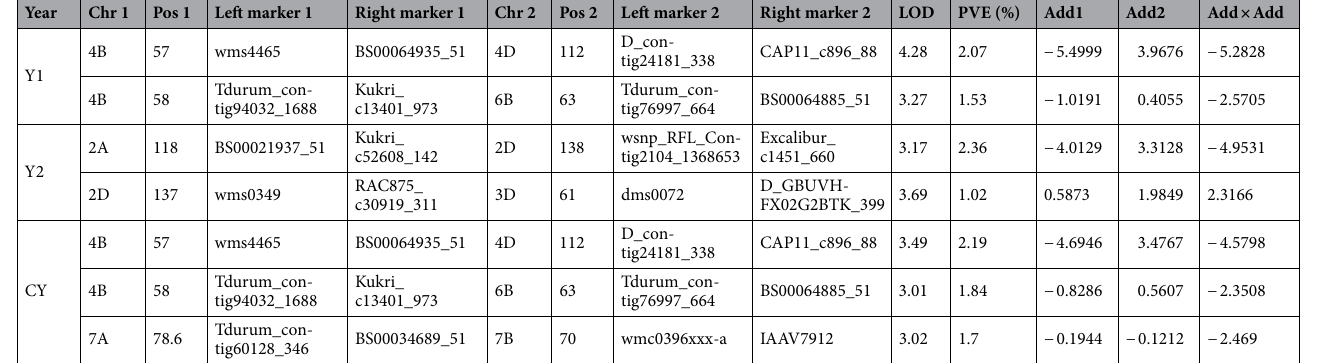
Table 2. Details of epistatic QTL interactions. Y: Year (Y1: Year 1; Y2: Year 2; CY: Combined data); Chr: Chromosome; Pos: Position; LOD: Logarithm of the odds; PVE: Phenotypic variance explained; Add: Additive